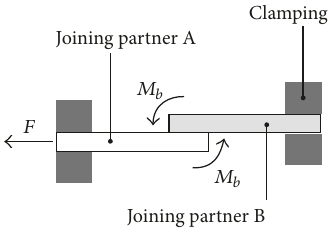
Figure 4: Overlap geometry of the vibration welding test specimen consisting of prestructured joining partner A (PA66) and joining partner B (HDPE).